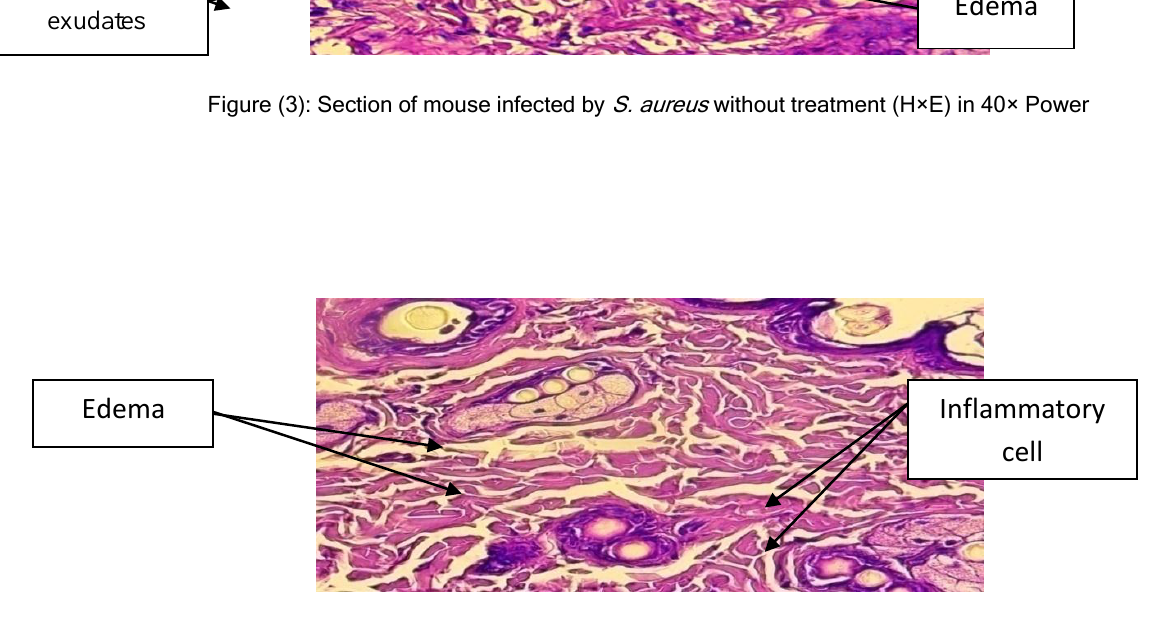
Figure (4): Section of skin specimen of mouse infected by S. aureus treated with T. Foenum- groecum (H×E) (40×)